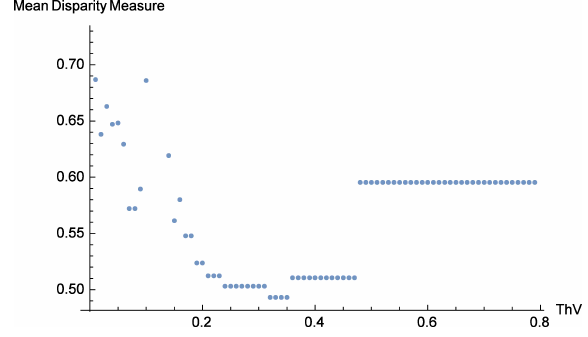
Fig. 2. The mean disparity measures < y > of each graph with respect to threshold